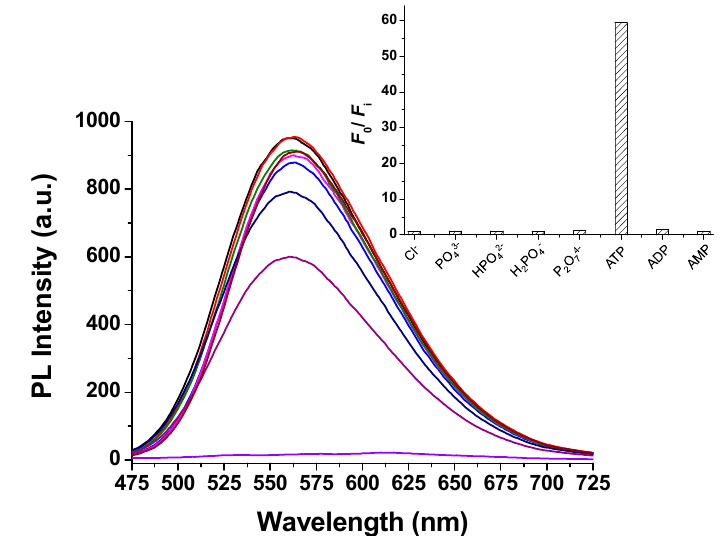
Figure 2. Fluorescent emission changes of L (10 μ M) upon addition of various bio-related sodium salts of anions including ATP, ADP, AMP, Cl − , PO 4 3 − , HPO 4 2 − , H 2 PO 4 − and P 2 O 7 2 − (30 µ M) in water at pH 7.4.